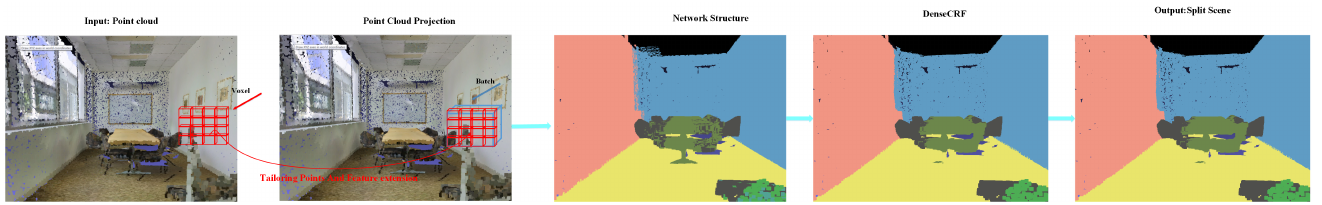
Figure 1. The overview of the proposed framework for semantic point cloud segmentation [36].